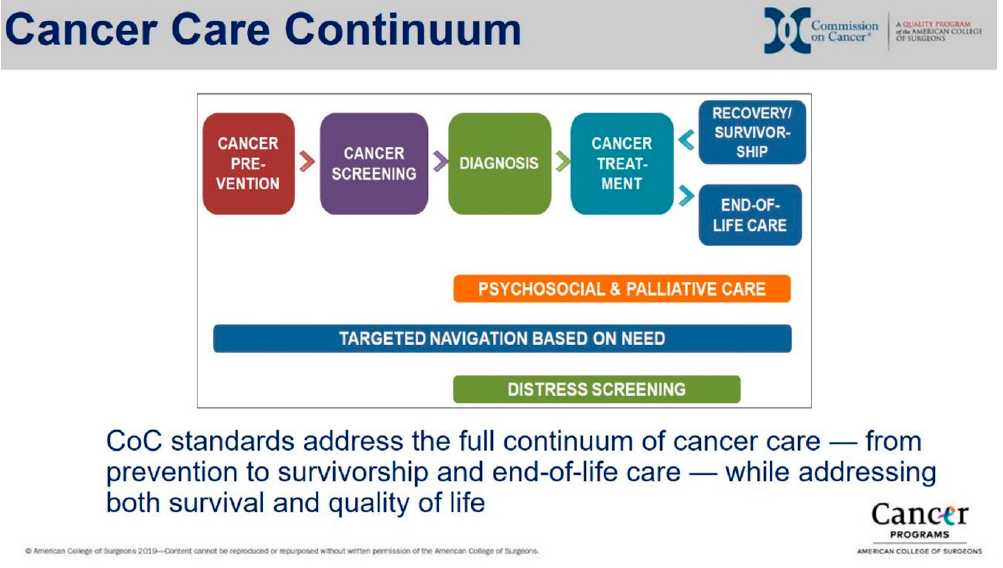
Figure 1. Cancer Care Continuum Domains. Permission to reprint from the American College of Surgeons’ Commission on Cancer (CoC).